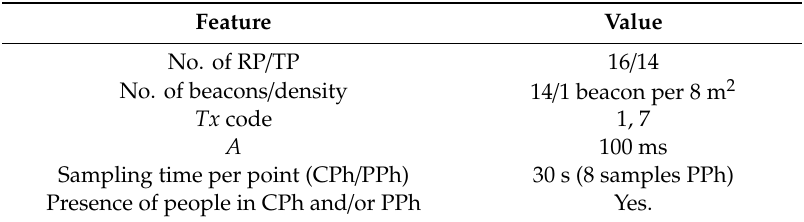
Table 23. Main features of Tests #9.